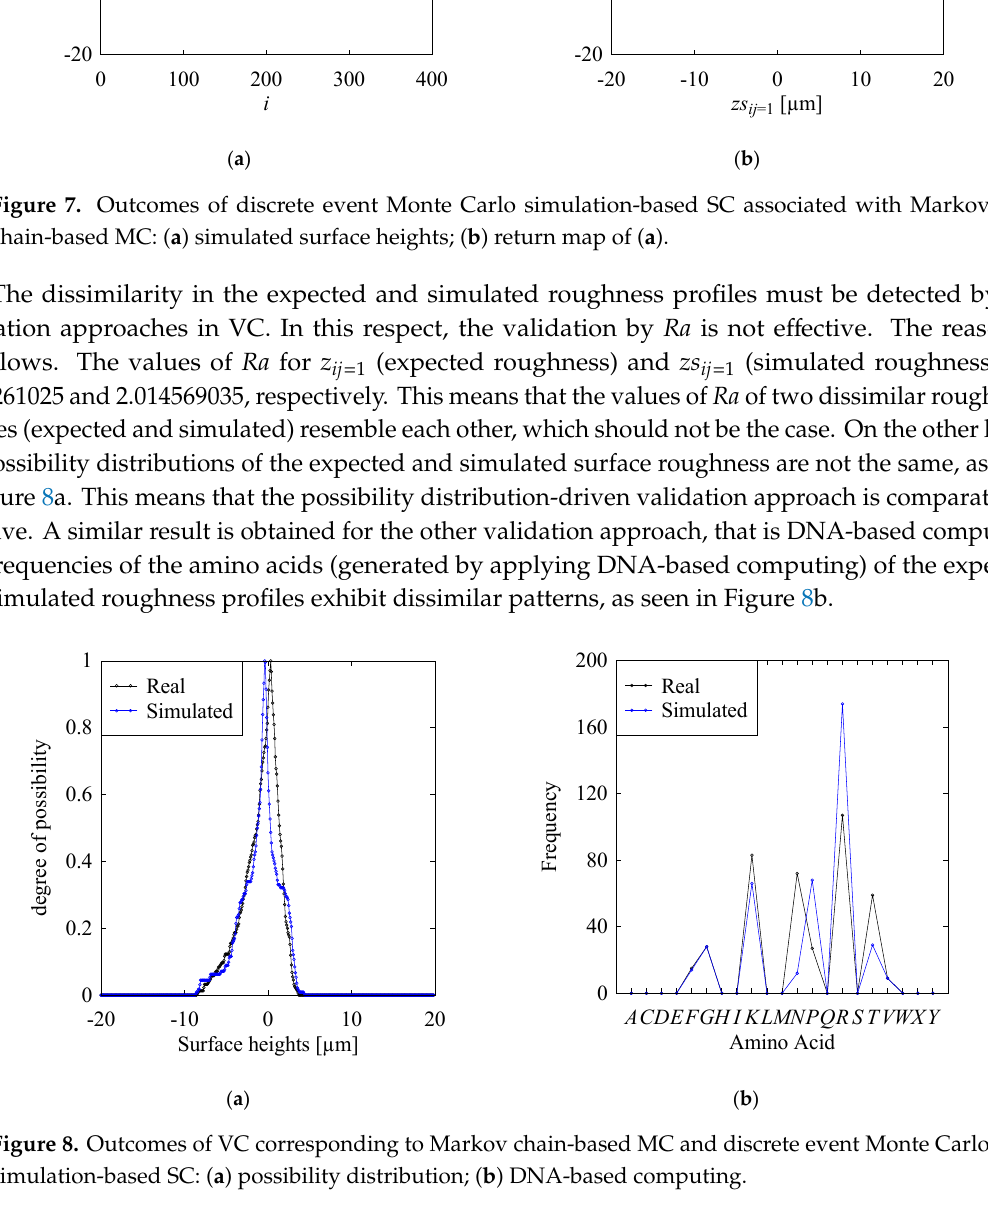
Figure 8. Outcomes of VC corresponding to Markov chain-based MC and discrete event Monte Carlo simulation-based SC: ( a ) possibility distribution; ( b ) DNA-based computing.